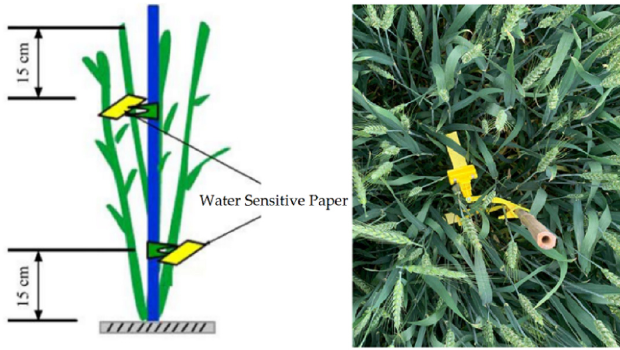
Figure 3. Arrangement of Water-Sensitive Paper [19].